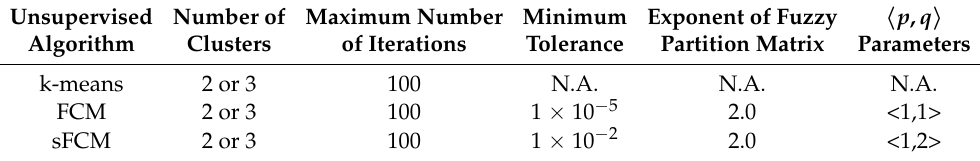
Table 2. Parameters setting for k-means, FCM and sFCM clustering algorithms.